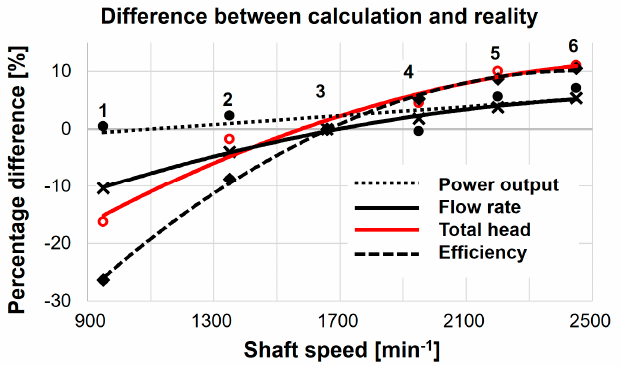
Figure 8. Comparison of predictive calculations with reality.